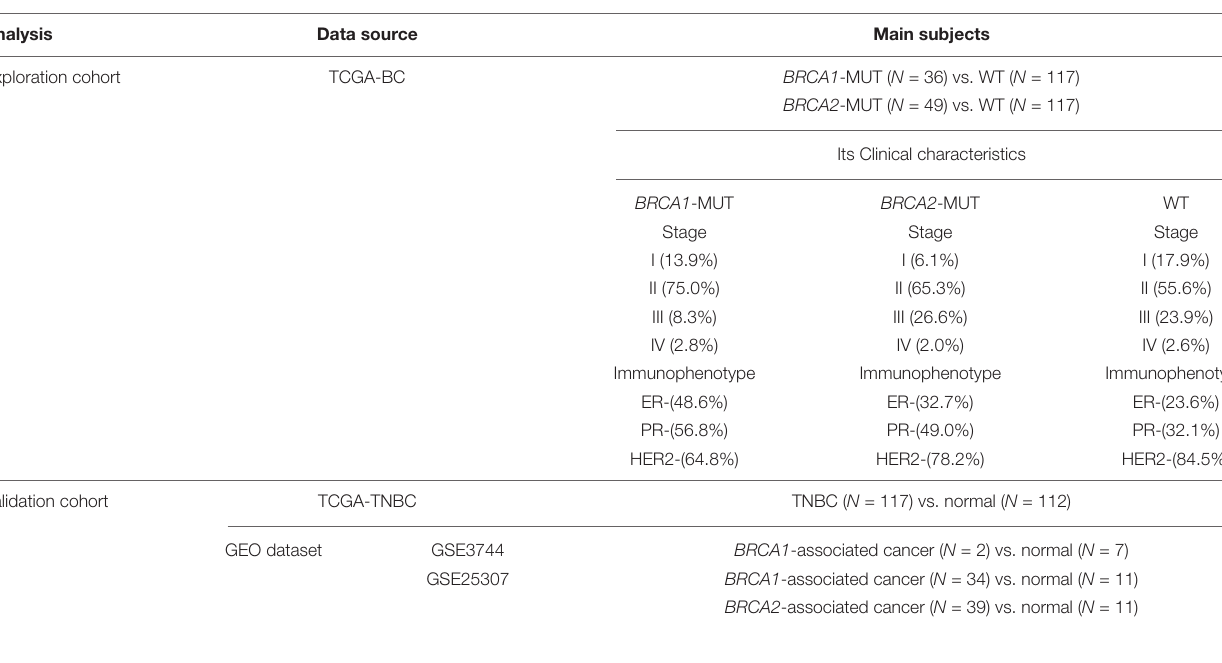
TABLE 1 | Main subjects used in this